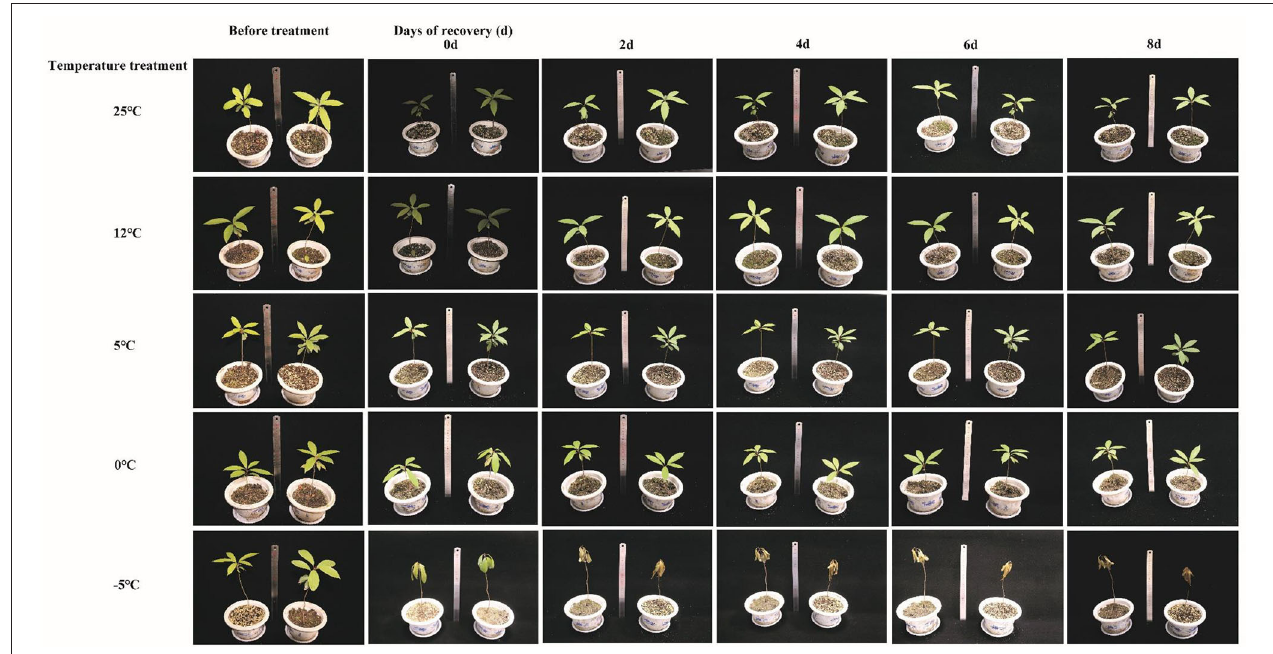
FIGURE 2 | Recovery of M. microcarpa after being treated at different